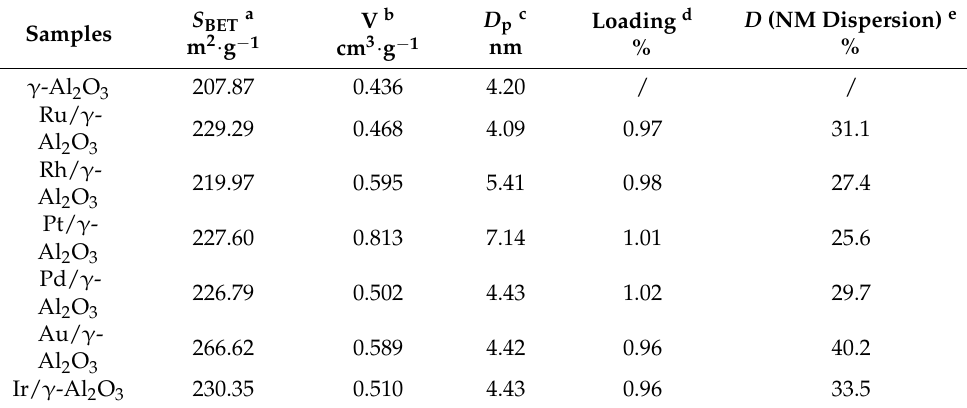
Figure 6. ( a ) N 2 adsorption-desorption isotherms curves and ( b ) Pore size distribution of all prepared catalysts. Table 2. Physicochemical properties of synthesized